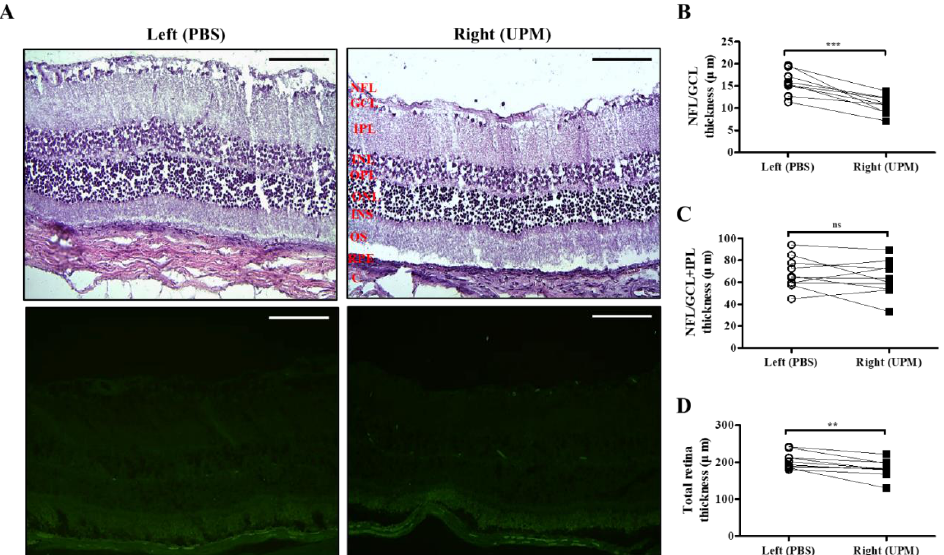
Figure 8. Effect of long-term exposure to UPM on retinal thickness and cell apoptosis. ( A ) The retinal images of H&E and TUNEL staining acquired at 16 weeks are shown. No apoptotic cells were detected by TUNEL staining. The scale bars indicate 100 μm for 200× magnification. Direct comparisons between the left and right eye thickness of NFL/GCL ( B ), NFL/GCL + IPL ( C ) and the total layers ( D ) determined by ImageJ software at 16 weeks are presented. ** p < 0.01, *** p < 0.001 vs. left eye. NFL, nerve fiber layer; GCL, ganglion cell layer; IPL, inner plexiform layer; INL, inner nuclear layer; OPL, outer plexiform layer, ONL, outer nuclear layer; IS, inner segment; OS, outer segment; RPE, retinal pigment epithelium; C, choroid. ns, not significant.